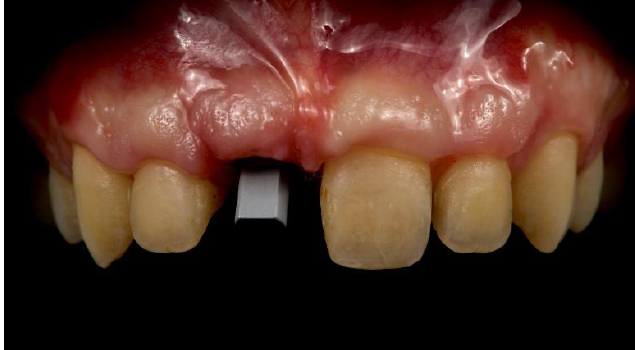
Figure 10. Intraoral digital impression taken using a scan body (Osstem Implant Co., Ltd., Seoul, Korea).